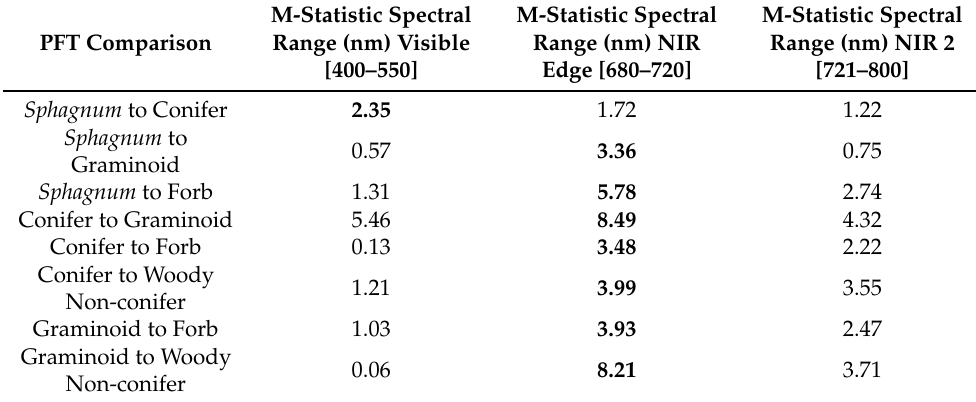
Table 3. Separability for the visible (400–550 nm), red edge (680–720 nm) and near infrared (NIR) (720–800 nm) regions, between taxa. The highest (most significant) M-statistics occur most frequently in the 680–720 nm